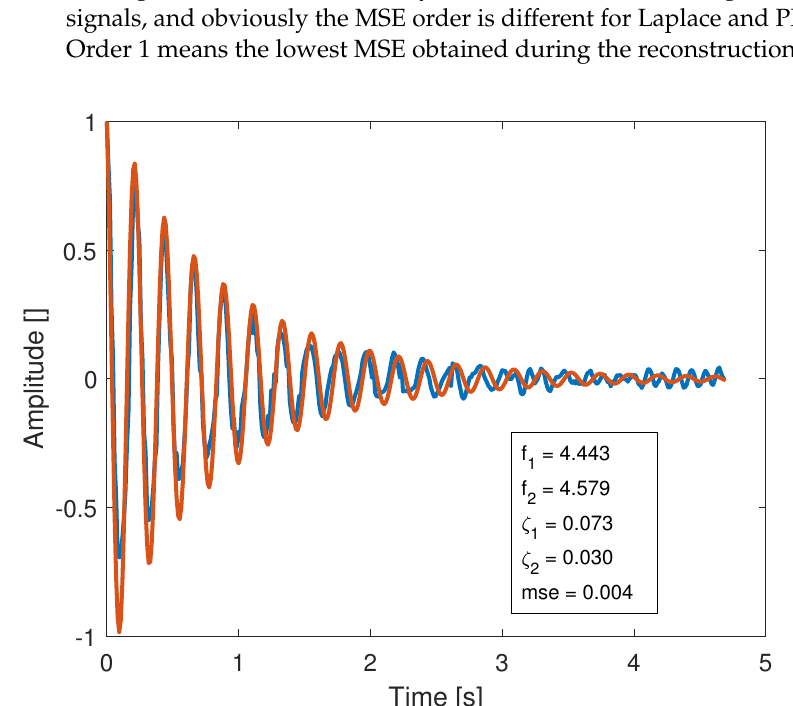
Figure 15. Original signal (blue) and signal reconstruction processed by the PRESTO technique (red). MSE order 7 (lower order means better